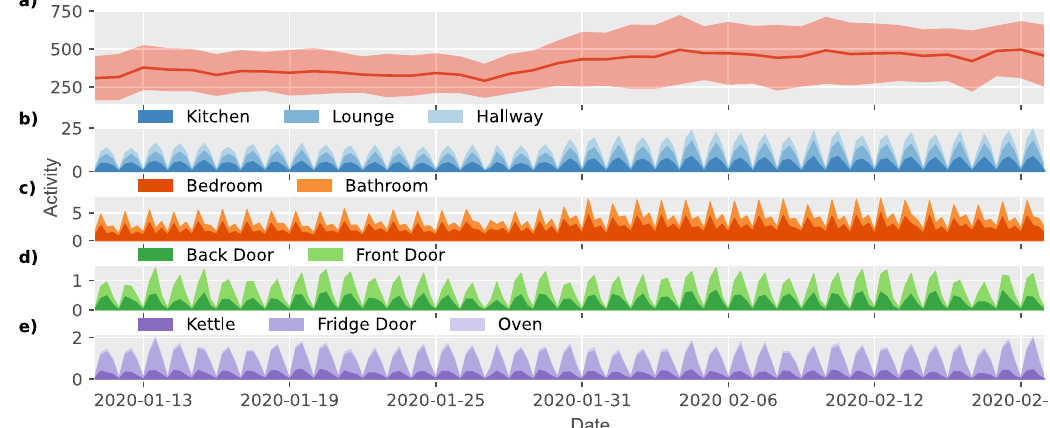
Fig. 2 Change in home activity at the transition between P1 (pre-COVID-19 baseline) and P2 (COVID-19 outbreak). a Total mean daily activity summed across households from 10 January 2020 to 20 February 2020 demonstrating gradual increase in activity during the initial outbreak period (light pink represents standard deviation per day); b – e Mean activity summed across the different sensors and locations sampled at a 6 h frequency demonstrates the daily behavioural cycle across different sensors as well as the gradual increase in activity as a function of covid.